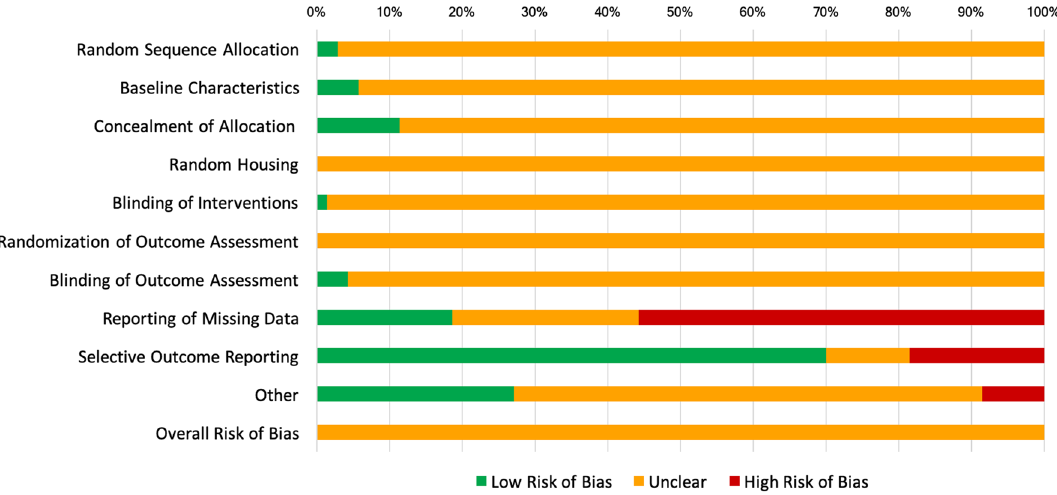
Figure 6. Risk of bias for the 70 included studies, using the SYRCLE ROB tool. Low risk of bias is represented in green, unclear risk in orange and high risk of bias in